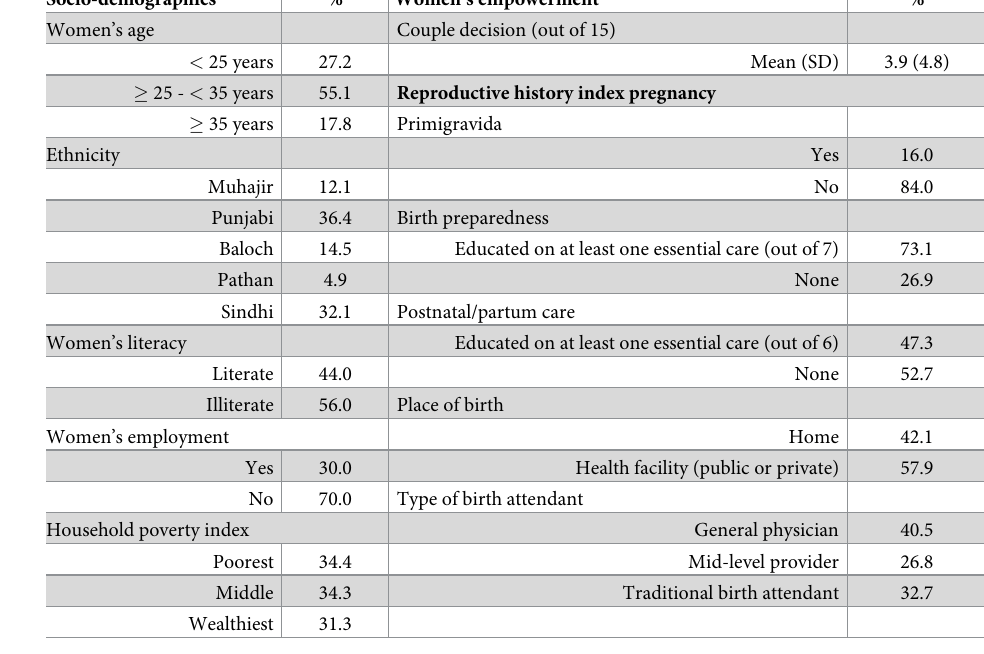
Table 1. Characteristics of the sample (n = 1,334). Socio-demographics % Women’s empowerment (cid:3)